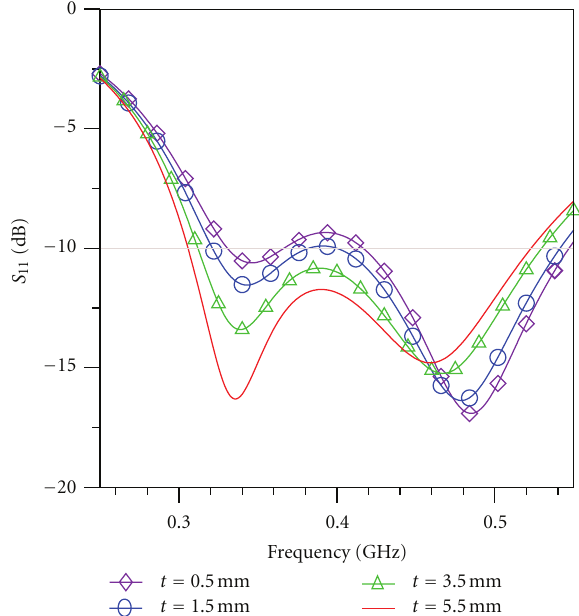
Figure 3: Simulated return loss for parameter of t in pork skin.